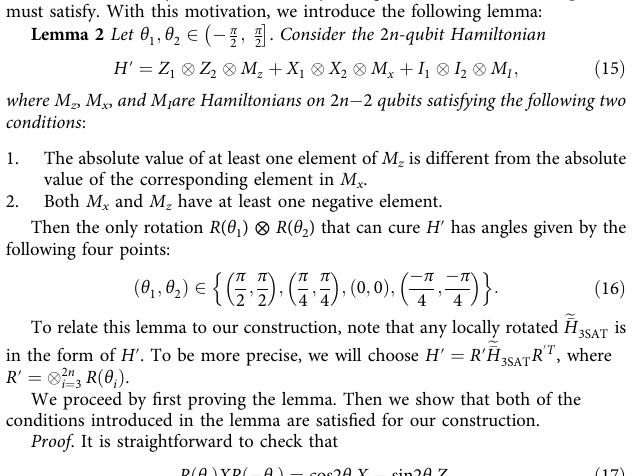
denote a rotation by angle θ i .